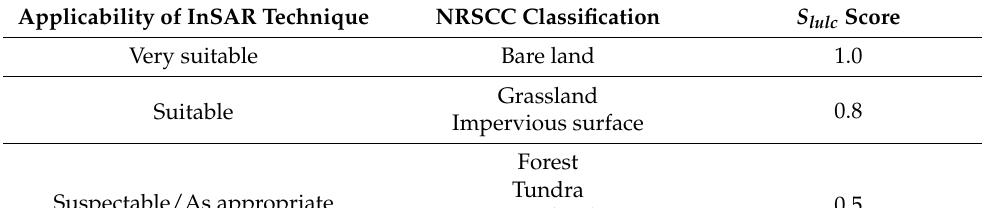
Table 4. The assessment rules of the land use/land cover (LULC).